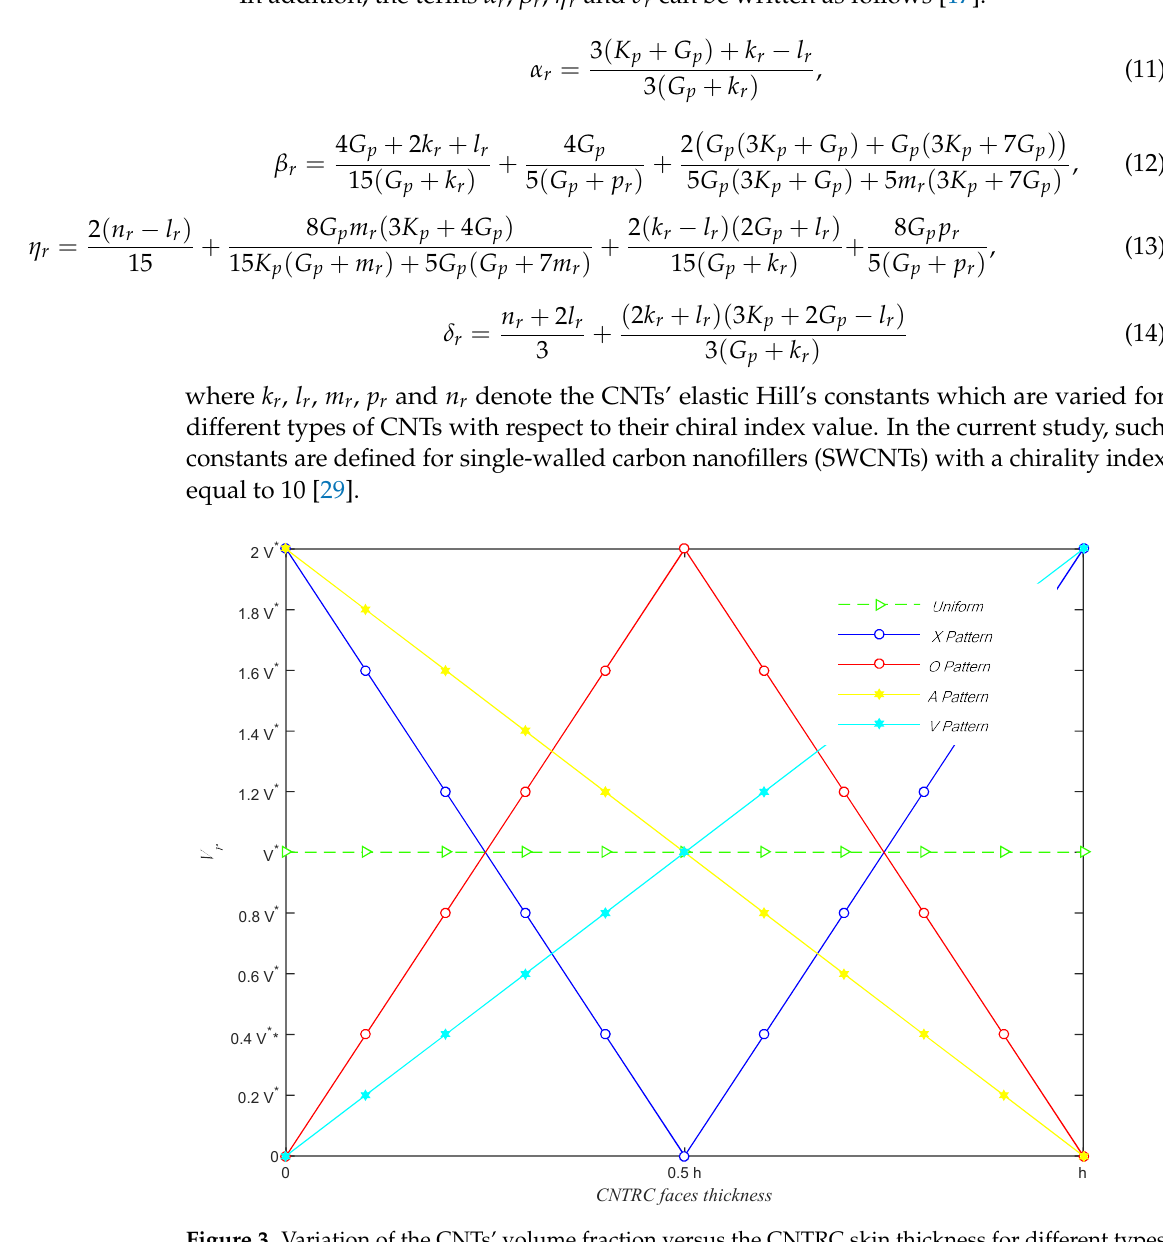
Figure 3. Variation of the CNTs’ volume fraction versus the CNTRC skin thickness for different types of CNTs’ patterns.